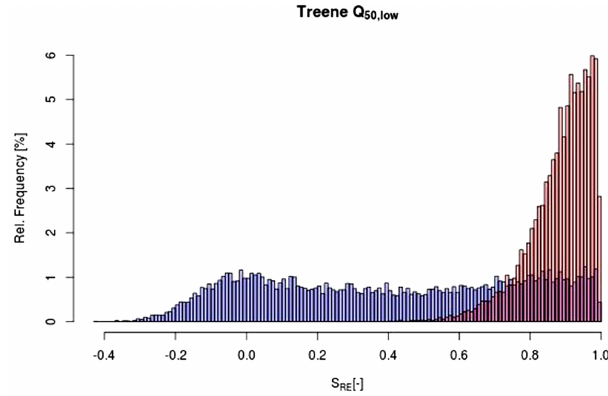
Figure 11. Histograms of the performance distributions for the me- dian of the low flows Q 50 , low for the Treene catchment on the basis of all feasible parameter sets of mHM (blue) and mHMtopo (red). The performance S RE is defined as 1 minus the relative error, lead- ing to an optimal value of